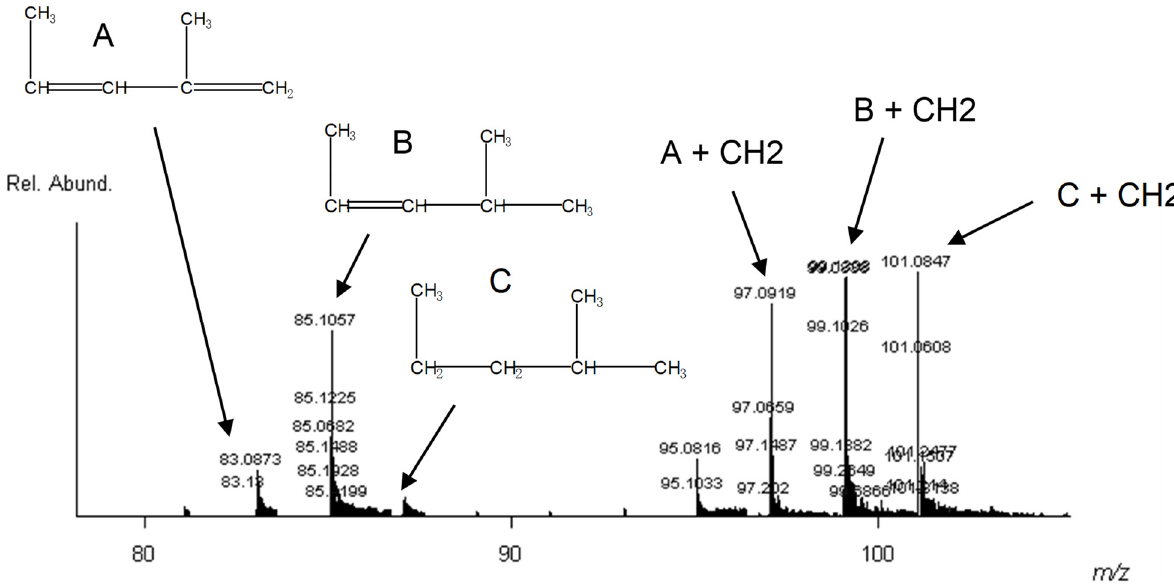
Figure 8. Close up of polypropylene standard mass spectrum (80–110 mass range). All peaks are protonated molecules of the indicated structures.